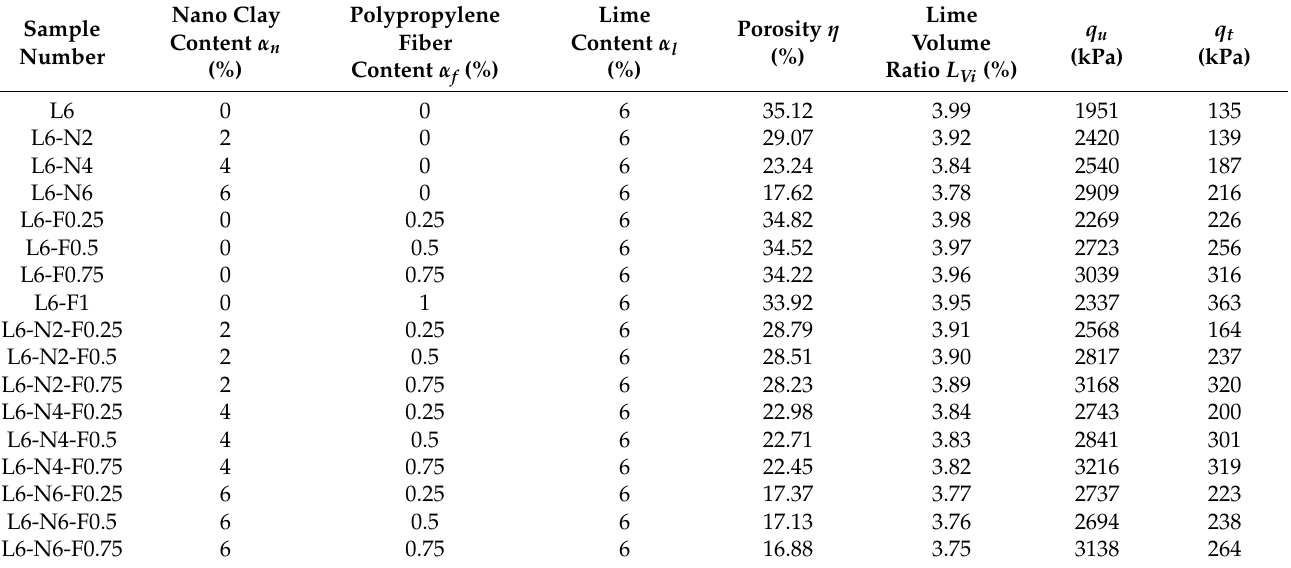
Table 4. Test scheme and test